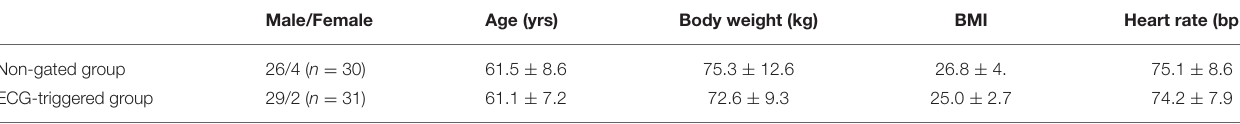
TABLE 1 | Patient characteristics.